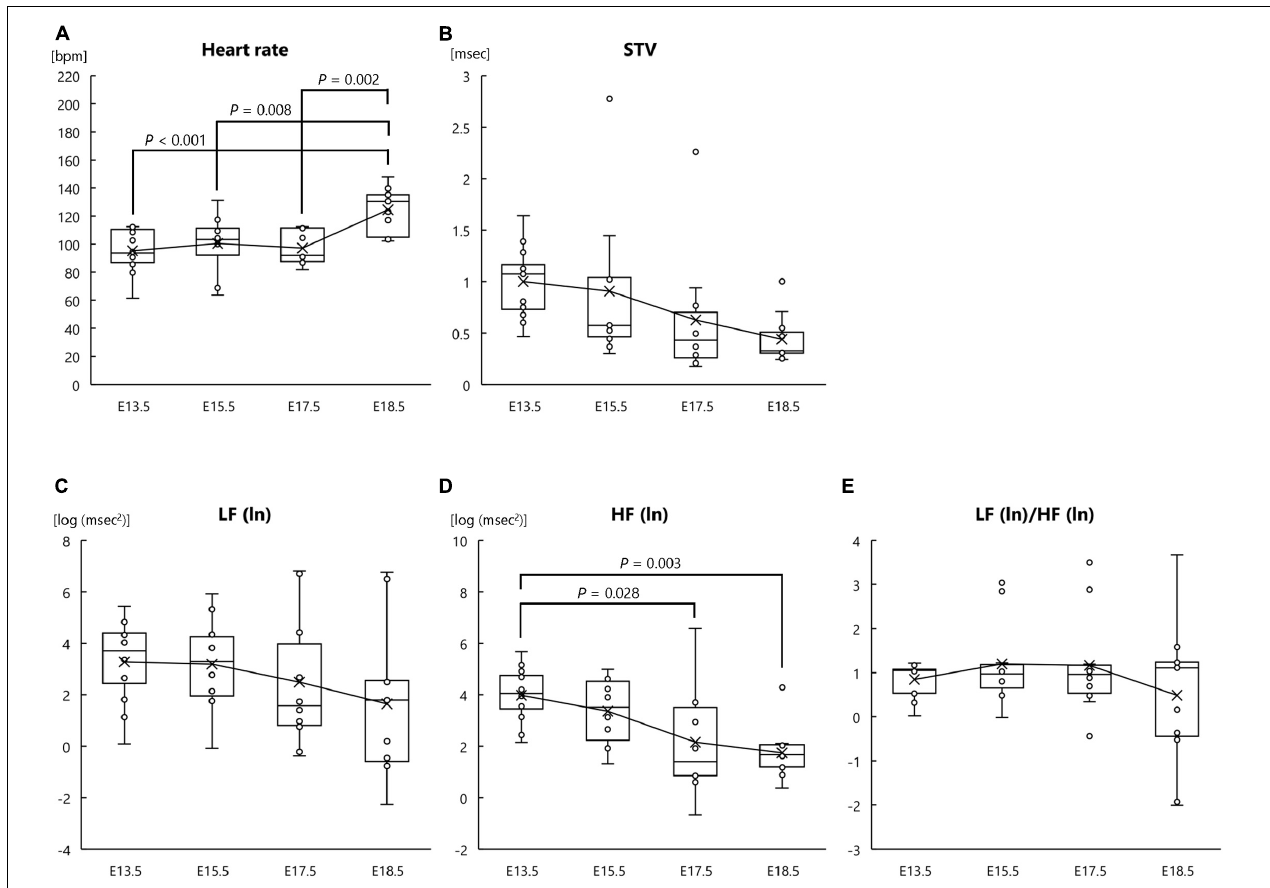
FIGURE 1 | Heart rate and autonomic nervous activities at each fetal stage in normal mouse fetuses. (A) Heart rate, (B) short-term variability (STV), (C) natural logarithm of the low-frequency of the power spectrum [LF (ln)], (D) natural logarithm of the high-frequency of the power spectrum [HF (ln)], and (E) the LF (ln)/HF (ln) ratio at the following fetal stages: embryonic day (E) 13.5 ( n = 12 fetuses from 8 mothers), E15.5 ( n = 10 fetuses from 5 mothers), E17.5 ( n = 10 fetuses from 6 mothers), and E18.5 ( n = 11 fetuses from 6 mothers). ECG signals were measured in pregnant mothers and fetuses at each fetal